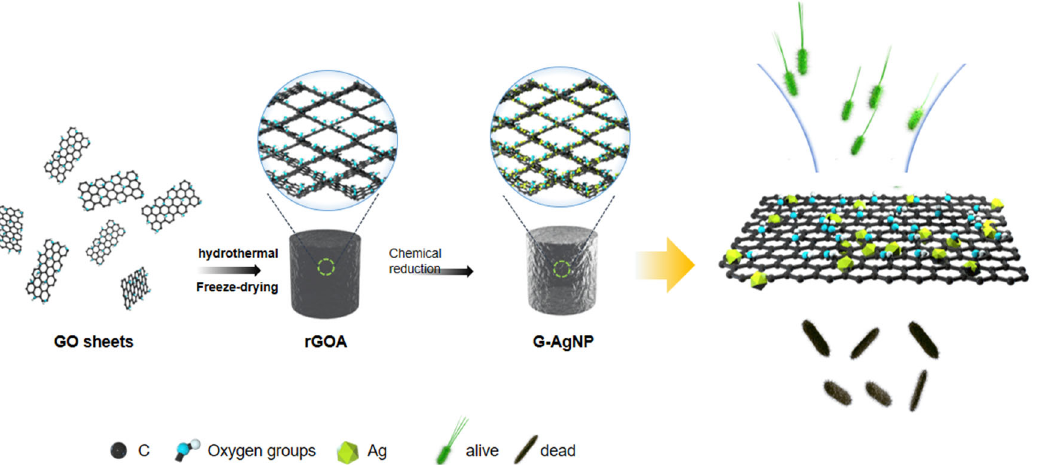
Figure 1. Schematic illustration of the 3D nano-silver-functionalized graphene antibacterial